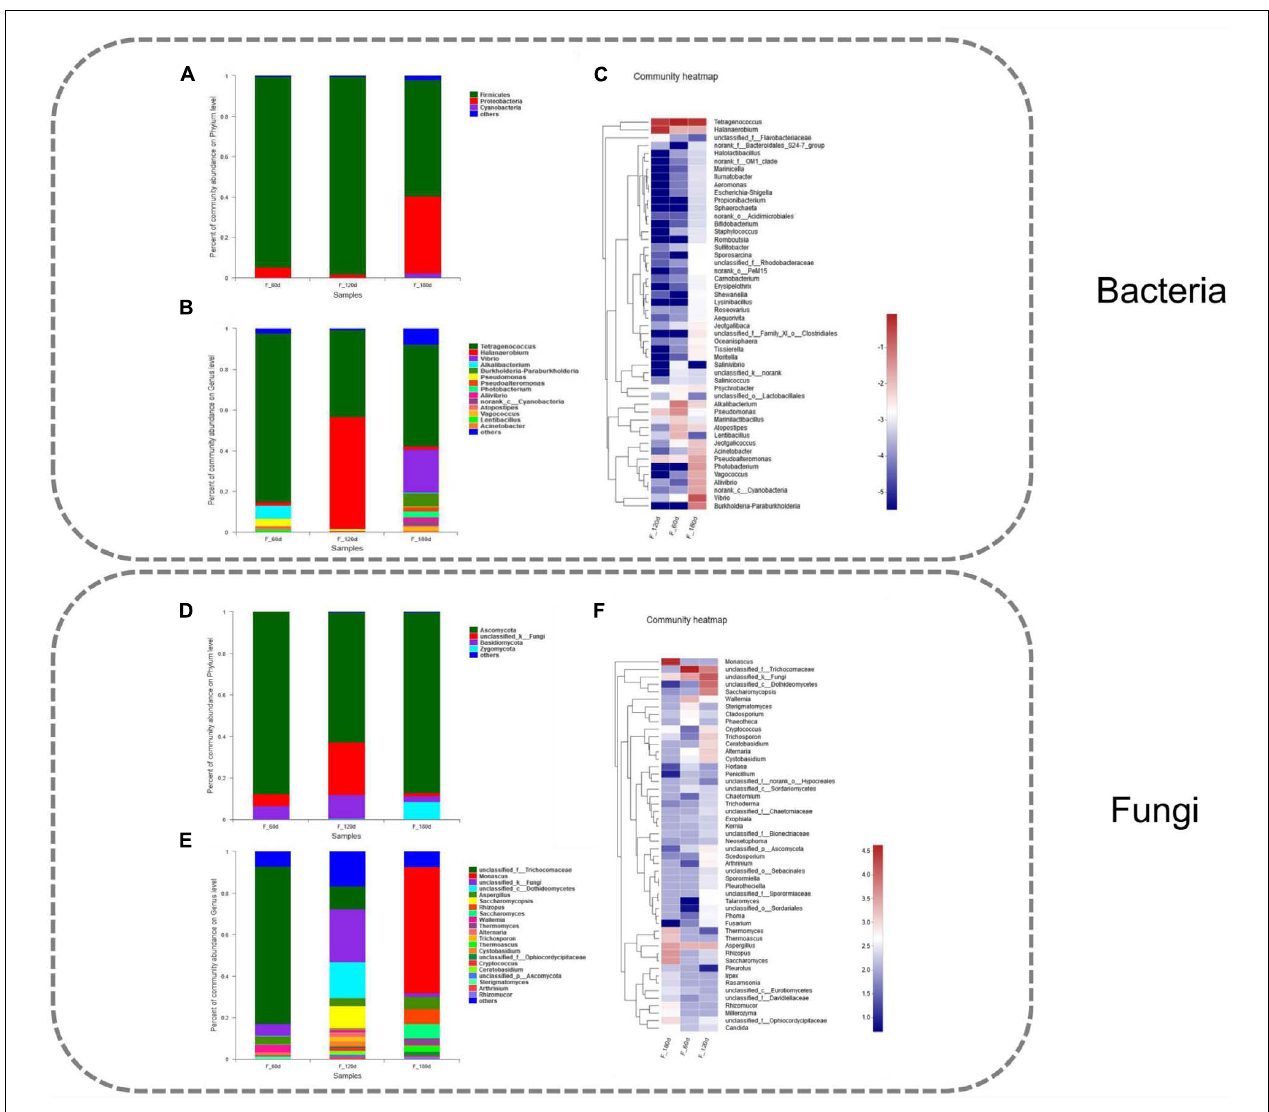
FIGURE 2 | Community composition of bacteria and fungi in grasshopper sub shrimp paste samples during fermentation. (A) Relative abundance of bacterial phyla, (B) Relative abundance of bacterial genus, (C) Heatmap dendrogram showing the diversity of bacteria at genus level, (D) Relative abundance of fungal phyla, (E) Relative abundance of fungal genus, (F) Heatmap dendrogram showing the diversity of fungi at genus